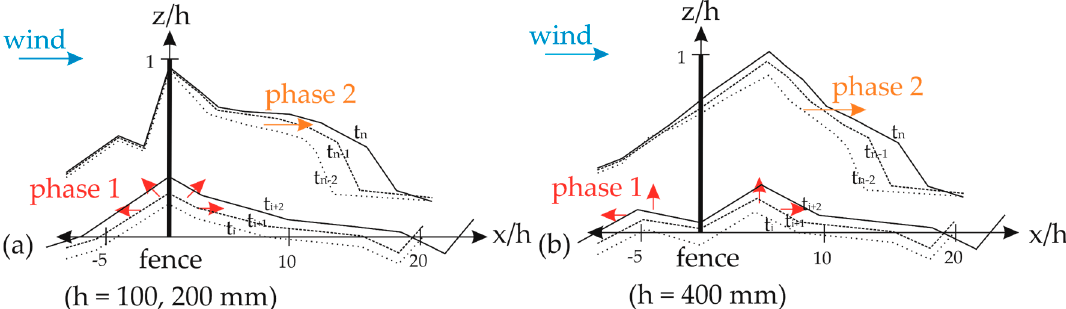
Figure 6. Schematic sketch showing two phases during dune establishment for ( a ) low and medium fences ( h = 100, 200 mm) and ( b ) high fences ( h = 400 mm). Dune establishment is shown over time, starting at time t i (shortly after starting experiment) until time t n (end of experiment); times shown correspond to low, medium, and high fences, and arrows show dune growth directions (adapted from